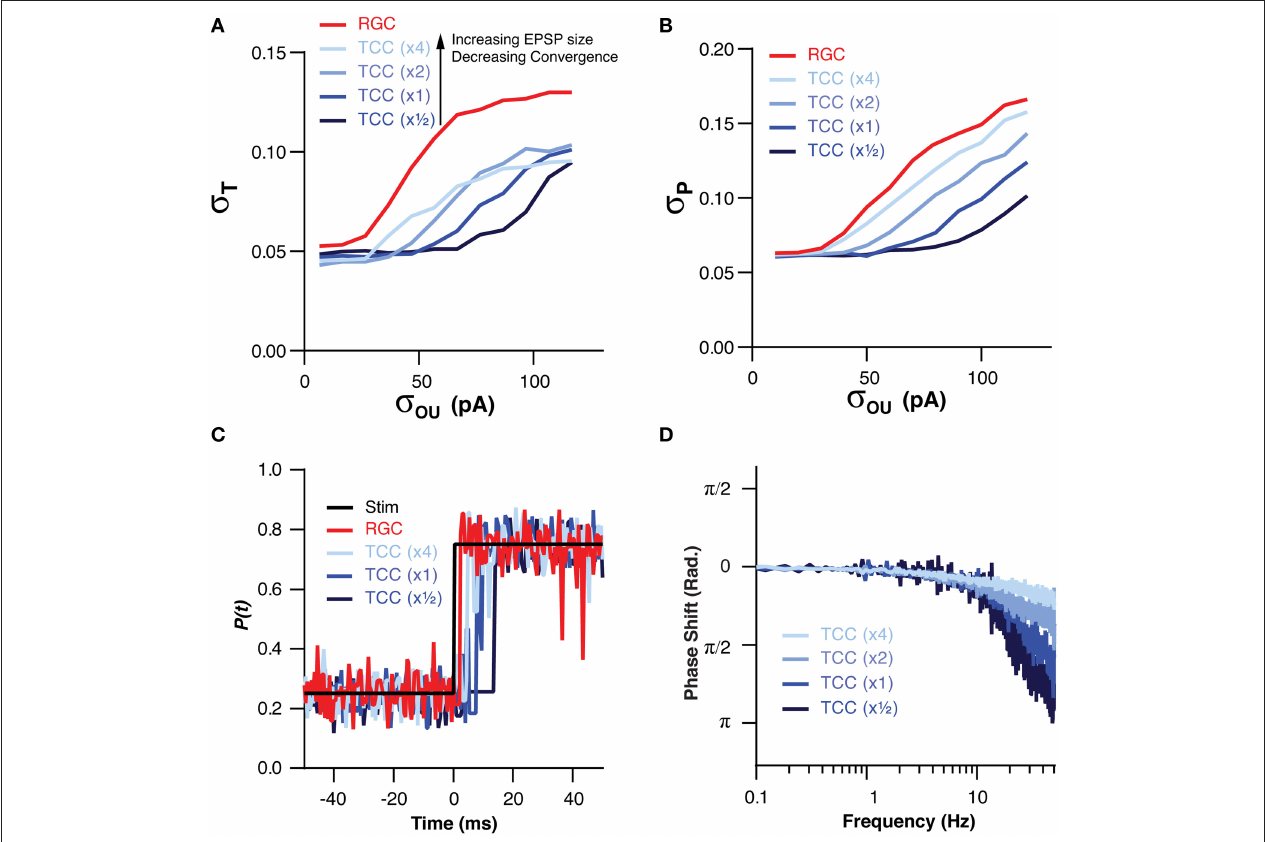
FIGURE 5 | The low pass effect of the TCC layer is robust to changes in the convergence of RGCs onto TCCs and EPSP size. (A) Across a range of convergence/EPSP sizes, the stability of encoding in the TCC layer was more robust to retinal noise than the RGC layer. Furthermore, increasing the convergence/decreasing the EPSP size produced a greater degree of robustness to noise. (B) The accuracy of encoding was higher in the TCC layer than the RGC layer across a range of convergence/EPSP sizes. Again, the higher the convergence/the lower the EPSP size, the greater the robustness to noise was. (C) Impulse response of the RGC and TCC layers across a range of convergence/EPSP sizes, showing that response delay increased as the convergence became higher/EPSP size became smaller. (D) The phase of the TCC response in relation to the stimuli across a range of convergence/EPSP sizes, clearly showing the slower response of networks with larger convergence and smaller